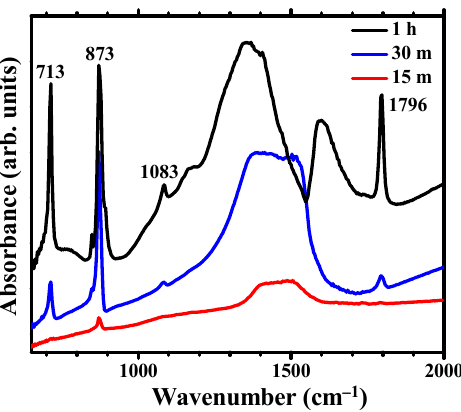
Figure 4. FTIR spectra showing the evolution for immersion times in carbonated water of 15 min, 30 min and 1h. The Raman spectra of Mg immersed for 1 h (Figure 5) have a strong, sharp feature at ~1086 cm − 1 . This band corresponds to the A 1g mode of the CO 3 polyhedra. Additional